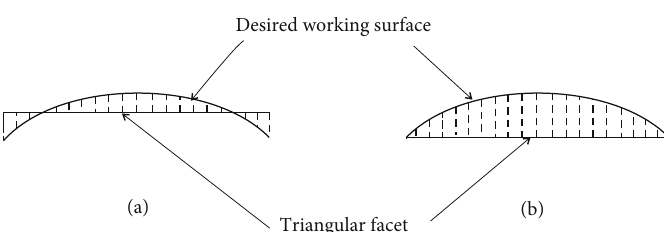
Figure 4: Triangular facet and desired working surface: (a) nodes are placed o ff the desired working surface and (b) nodes are placed on the desired working surface.